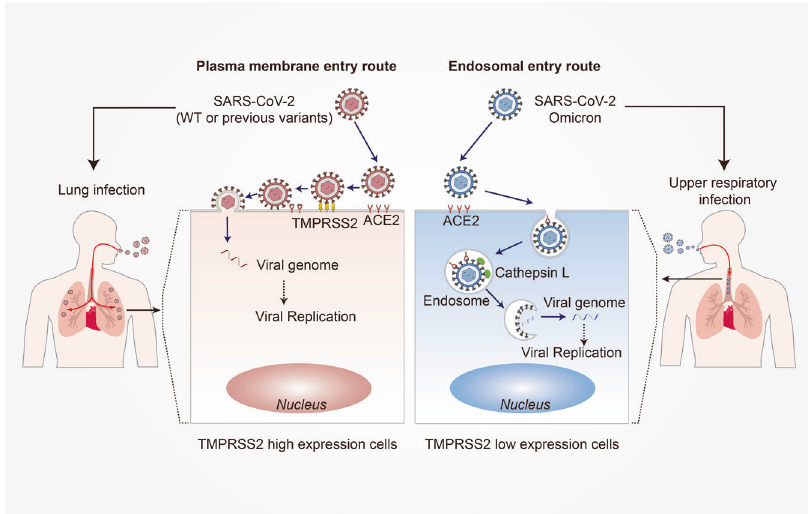
Fig. 2 The different entry routes and pathogenesis between SASR-CoV-2 WT or previous variants and Omicron variant. Left: SASR-CoV-2 WT or previous variants mainly infect lung epithelial cells, which are TMPRSS2 high expressed cells, and enter host cells by plasma membrane route. In the plasma membrane entry route, virus fi rst binds to ACE2, then binds to TMPRSS2 and is cleaved at the S proteins. Next, the S protein anchors to the cell membrane and mediates fusion of the viral membrane with the cell membrane. Finally, a pore is formed in the membrane and the viral genome is released into the cell. Right: SASR-CoV-2 Omicron variant mainly infects the upper airway epithelial cells, which are TMPRSS2 low-expressed cells, and enter host cells by the endosomal route. In the endosomal entry route, a virus fi rst binds to ACE2 and the virus – ACE2 complex is internalized via endocytosis into the endosomes, where S protein is cleaved by Cathepsin L. Then the viral and endosomal membranes are fused together to form a pore and release the viral Omicron S protein can bind to human ACE2 or ACE2 orthologs of different animal species to enter the target cells. 20 These fi ndings indicate the zoonotic potential of the Omicron variant, which could contribute to the development of highly infectious variants. Host-cell entry The entry of SARS-CoV-2 into the host cells after binding to host receptors is mediated by the S protein. The S protein is composed of S1 and S2 subunits. 21 The S1 subunit contains the RBD, which binds to ACE2, whereas the S2 subunit contains the transmem- brane portion of the S protein, which is responsible for anchoring the S protein to the membrane and mediating fusion of the viral membrane with cellular membranes. 22,23 Cleavage of the S protein at the S1 – S2 and S2 sites, mediated by furin 24 and type II crucial for viral entry into host cells. Cleavage by TMPRSS2 and cathepsin L at the S2 site mediates two distinct SARS-CoV-2 entry pathways. As TMPRSS2 is present on the cell surface, TMPRSS2 mediates the plasma membrane route of entry, whereas cathepsin L in the endosome mediates the endosomal entry route. 22